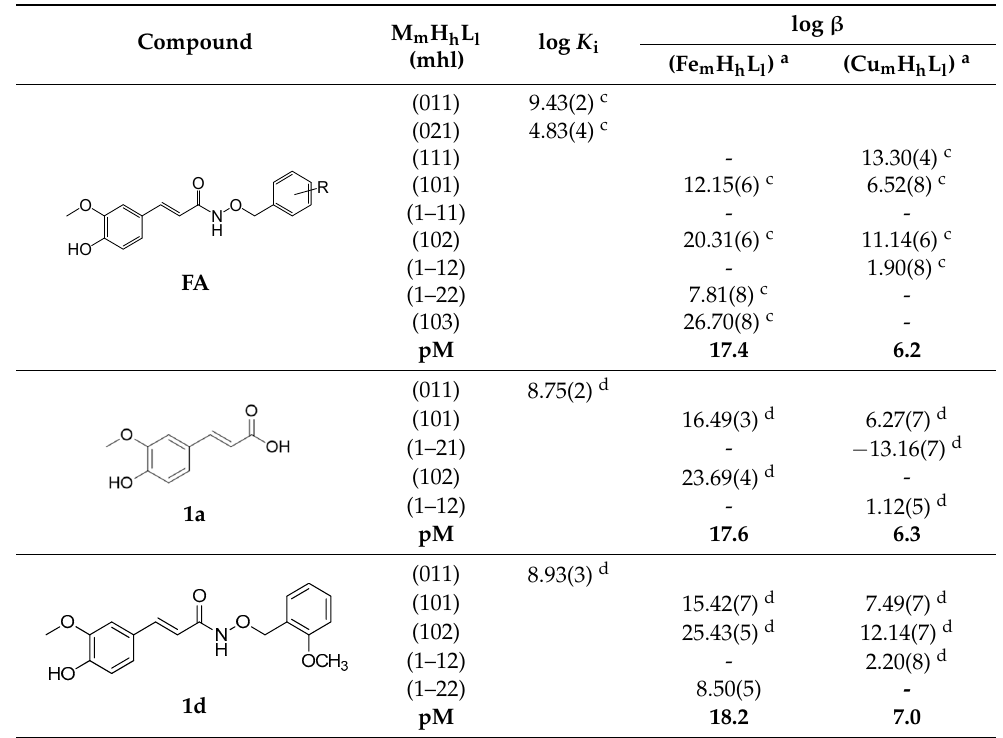
Table 2. Stepwise protonation constants of FA , 1a , and 1d as well as global formation constants a of their Fe 3+ , Cu 2+ complexes and corresponding pM b values. ( T = 25.0 ± 0.1 ◦ C, I = 0.1 M KCl, 20% w/w DMSO/water).